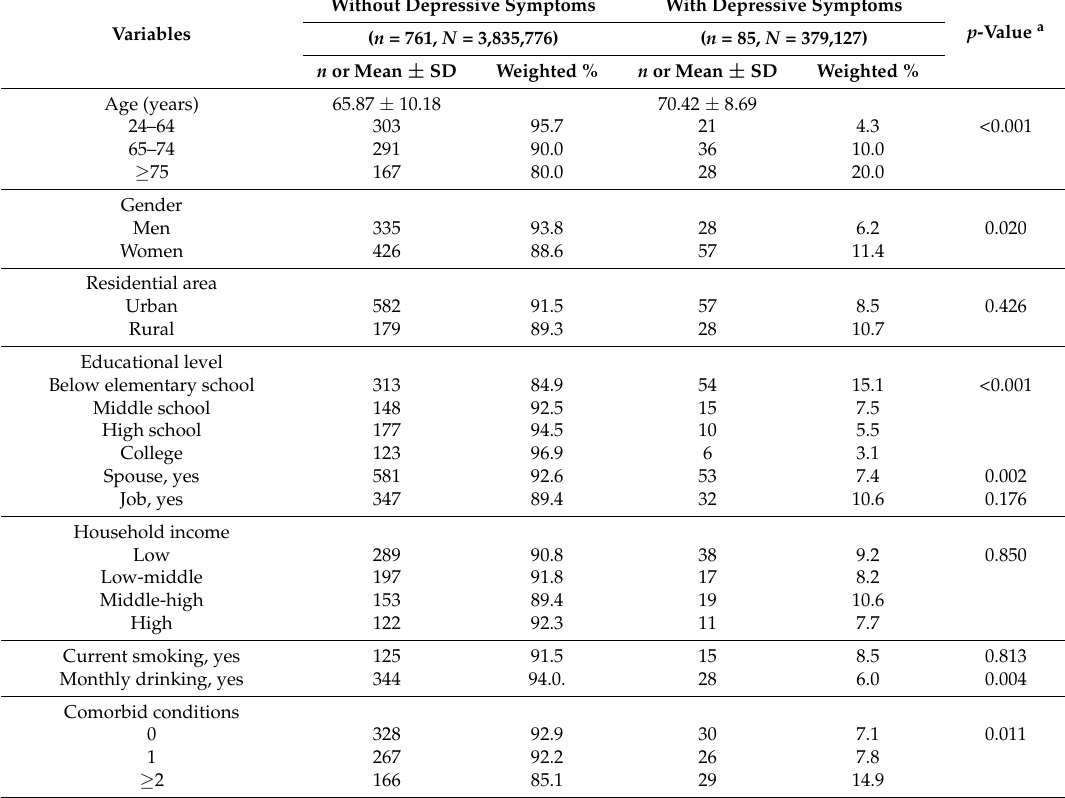
Table 1. Comparison of characteristics of hypertension patients with and without depressive symptoms ( n =